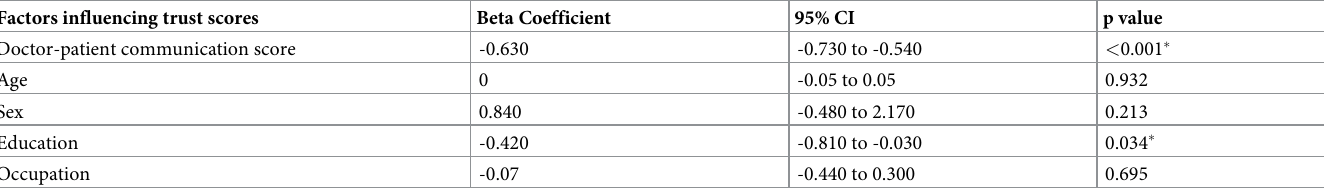
Table 6. Association between doctor patient communication and trust in the